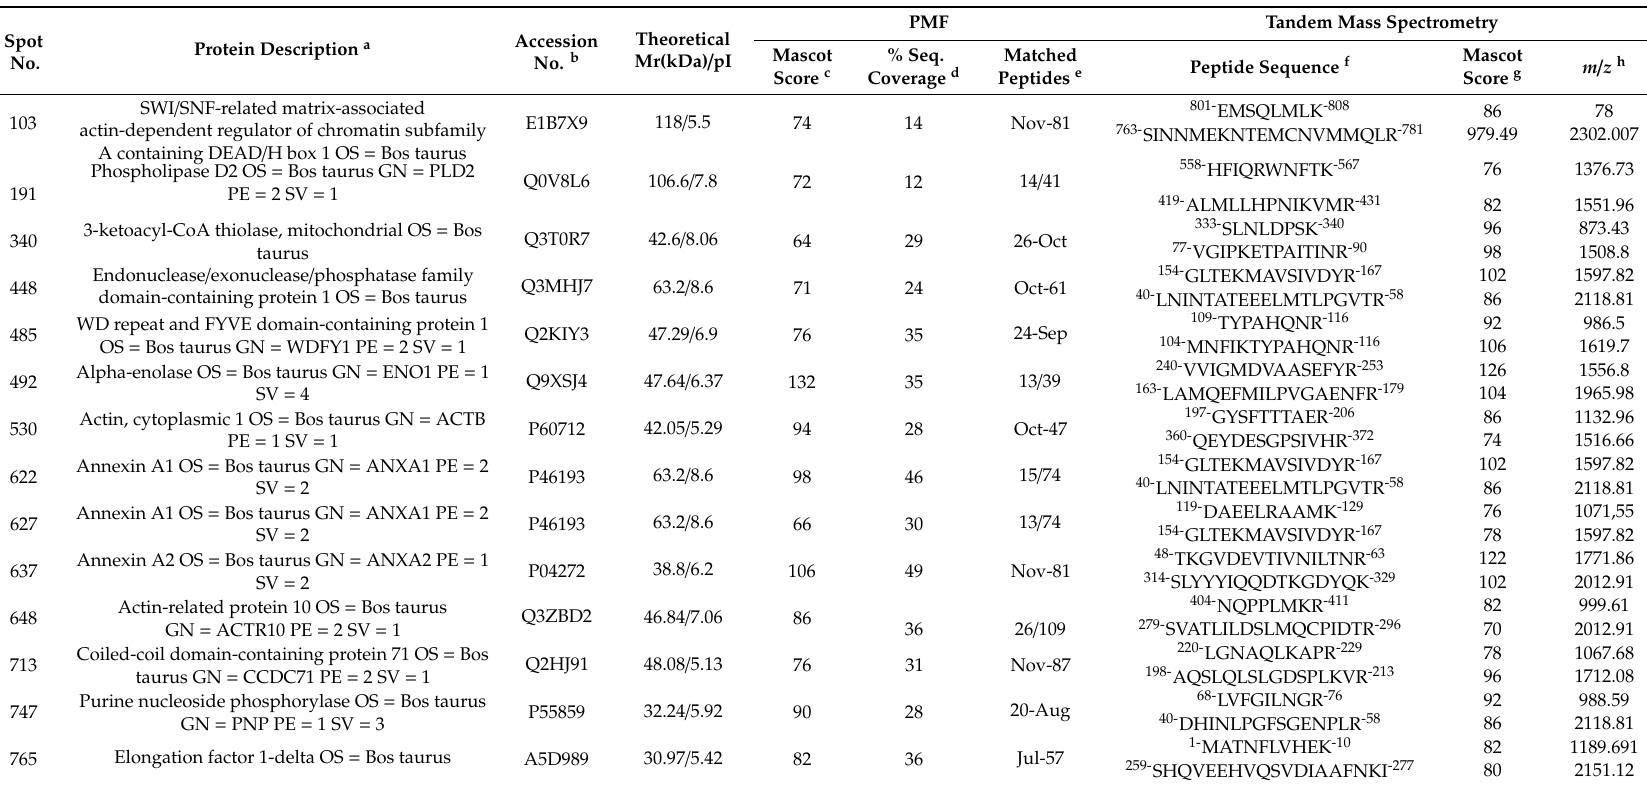
Table 2. Summary of the MS-data for protein identification. a Name of identified proteins; b Accession No. according to Swiss-Prot database; c Peptide mass peptides matched versus searched peptides; f Aminoacidic sequence of the peptides identified by MS / MS analysis, and g Related score calculated by MASCOT 2.4.1 algorithm. The underlined letter indicates oxidation of methionine residue; h Monoisotopic masses of the parent ions used for MS / MS analysis. Spot